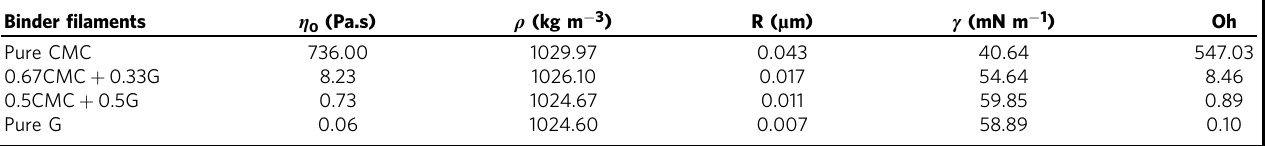
Table 2 Ohnesorge number calculation. Binder fi